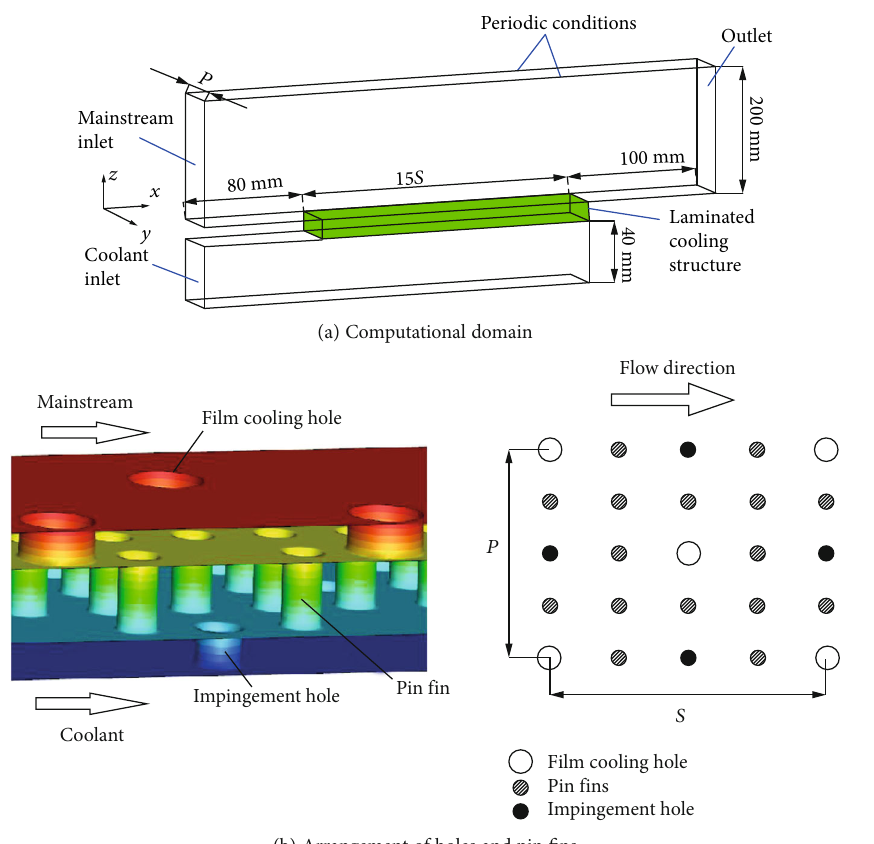
Figure 2: Geometry of computational domain.